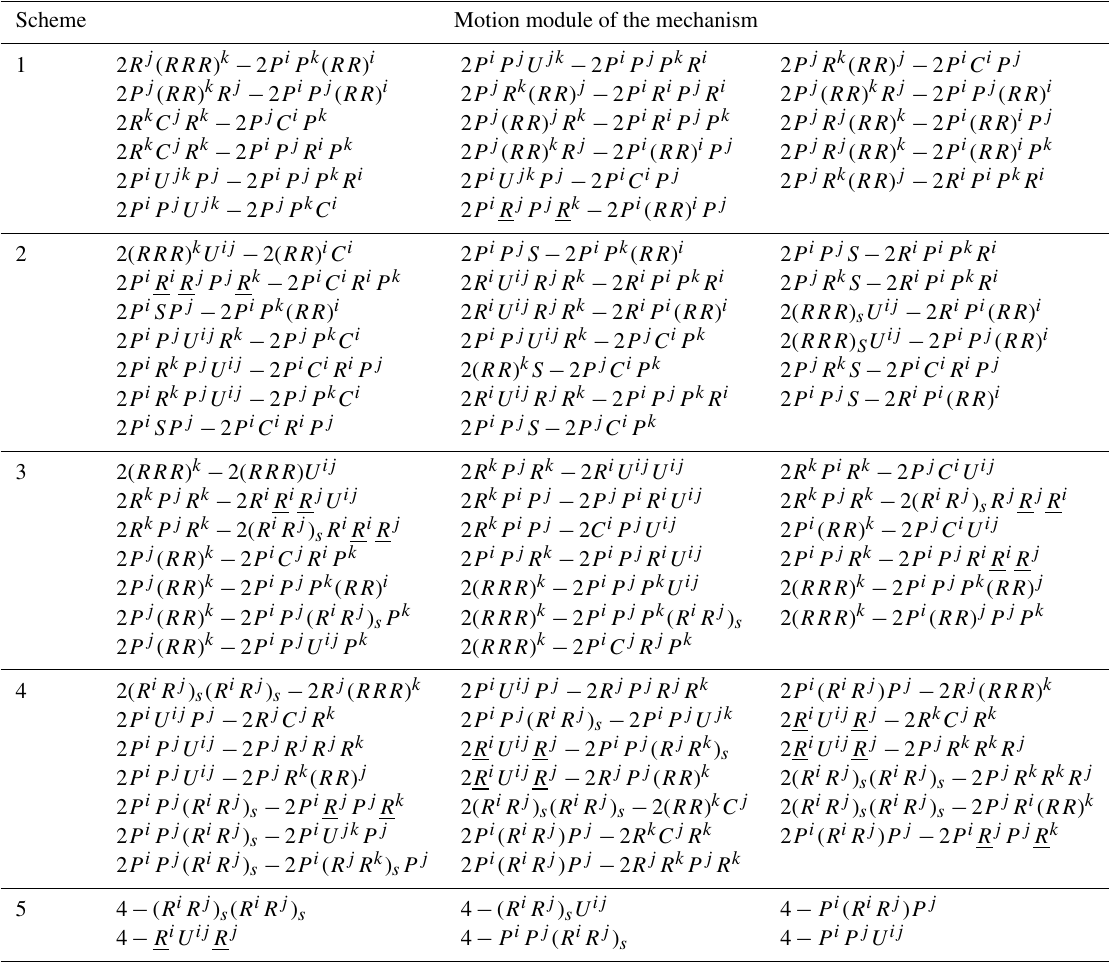
Table 7. The motion modules of the